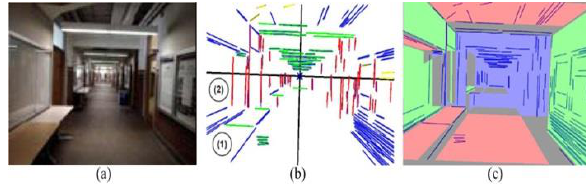
Figure 4. Single image, line segments and orientation map. (a) Single image. (b) Detected straight line segments, vanishing point, and two of vanishing lines. (c) Orientation map; regions are colorized according to their orientations.